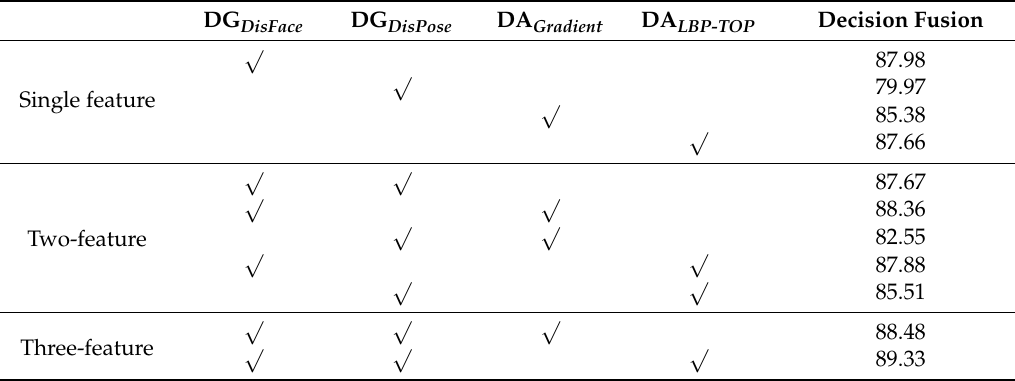
Table 1. Comparison of diverse dynamic facial feature combination